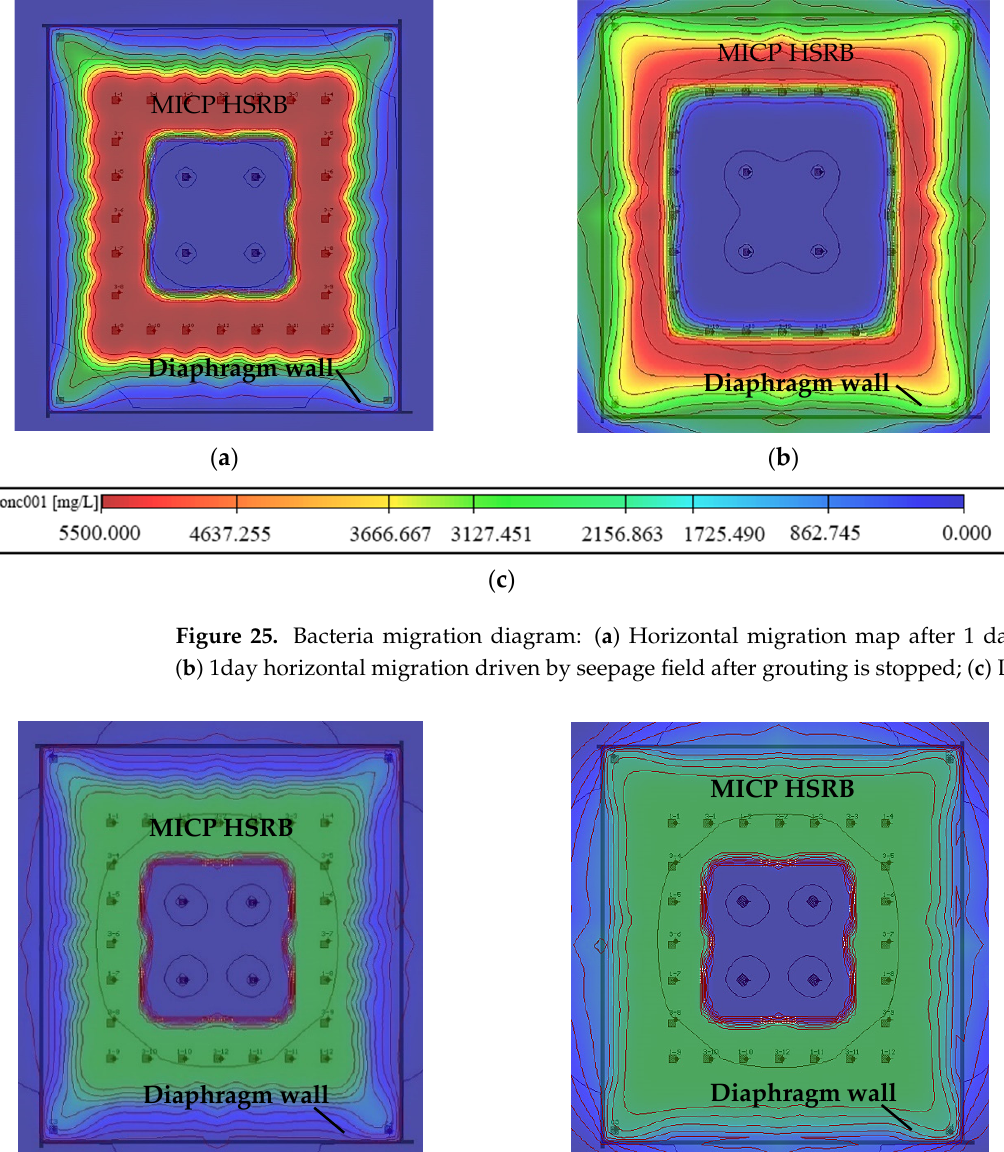
Figure 25. Bacteria migration diagram: ( a ) Horizontal migration map after 1 day of perfusion; ( b )